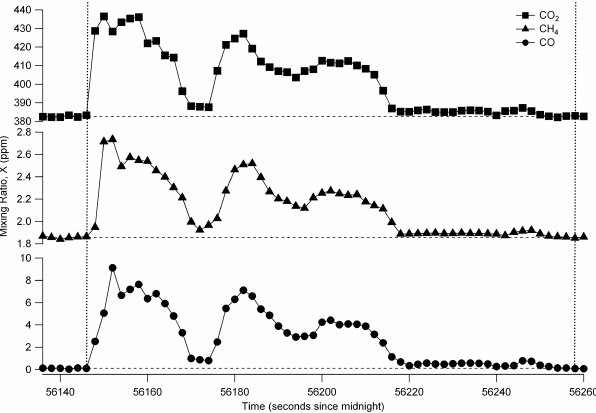
Fig. 2. CRDS measurements of CO 2 , CH 4 , and CO for a smoke sample run on the Saddle Complex on 24 August 2011. The hori- zontal dashed line in each panel shows the background mixing ratios measured upwind of the fire on approach for the smoke sample. The vertical dotted lines mark the start and end of the